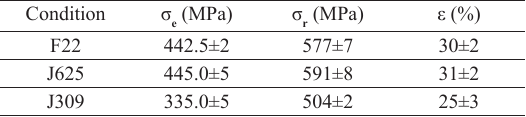
Table 3. Mechanical resistance of the J625 and J309 welded joints, and of the F22 steel according to ASTM A182 F22 23